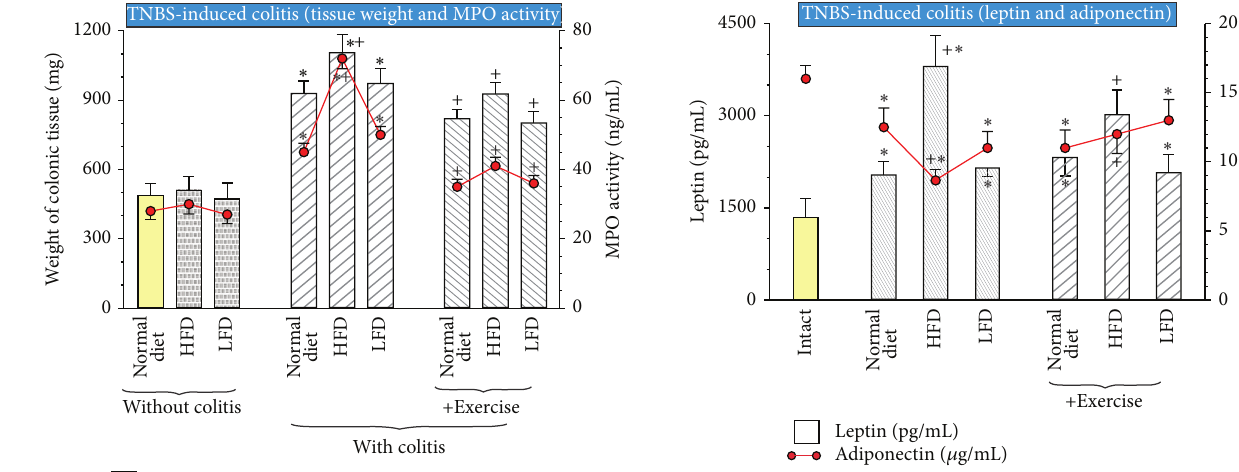
Figure 6: The effect of exercise on the plasma levels of leptin and adiponectin in trained and untrained rats fed normal diet, HFD, or LFD. Results are mean ± S.E.M. of seven animals per each experi- mental group. Asterisk indicates a significant change ( 𝑃 < 0.05 ) as compared with respective values in intact rats. Asterisk and cross indicate a significant change ( 𝑃 < 0.05 ) as compared with respective values in animals fed with normal diet or LFD. Cross indicates a significant change ( 𝑃 < 0.05 ) as compared with those obtained in untrained